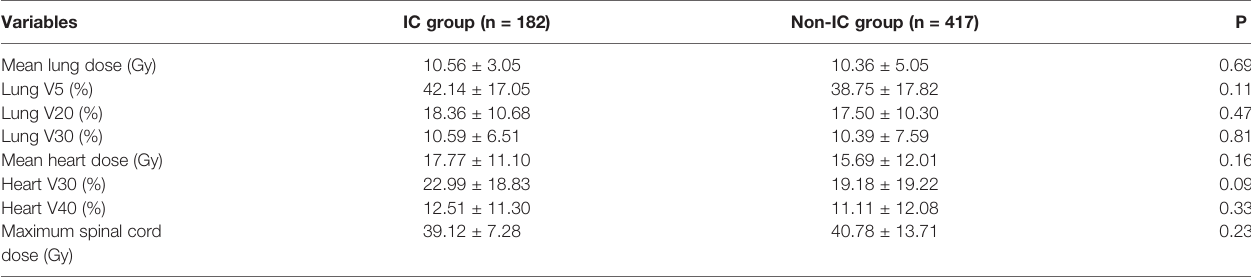
TABLE 3 | Comparison of radiation dose to OARs between the two groups.